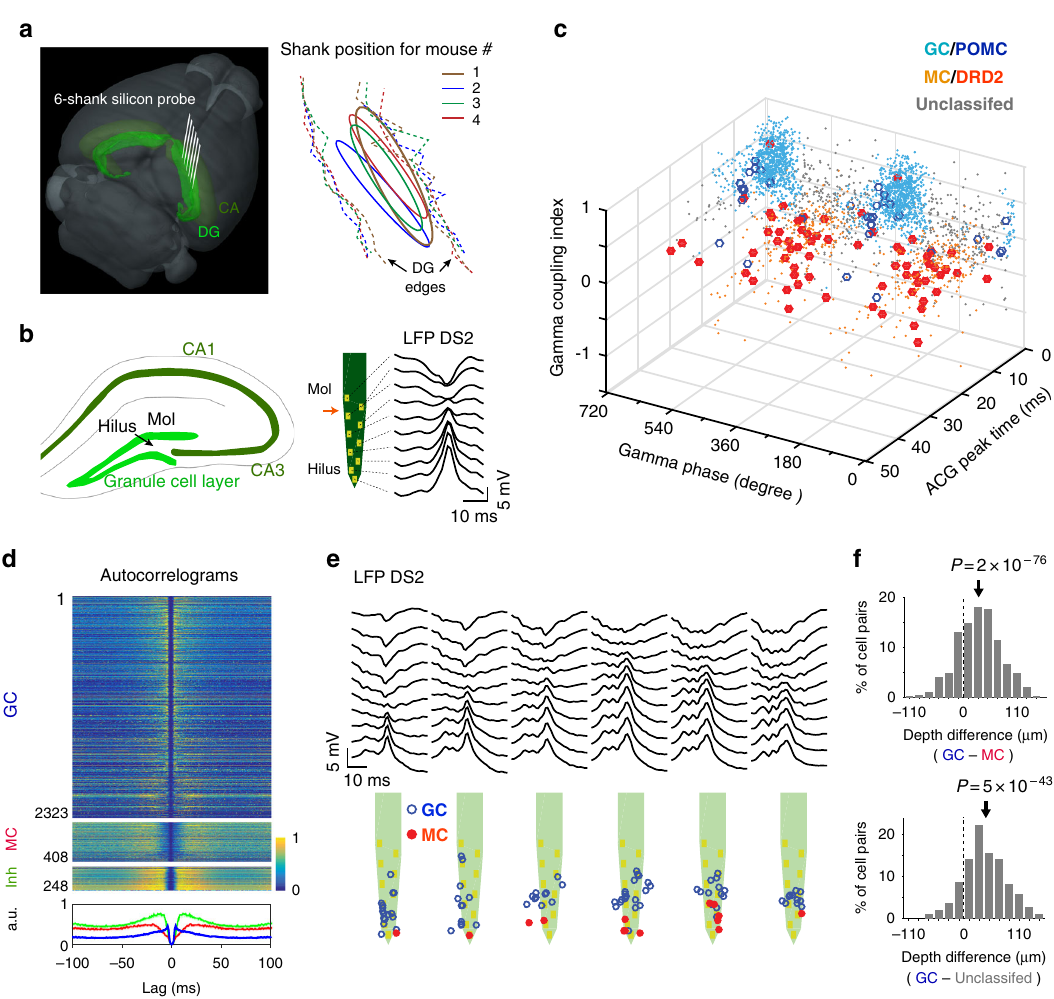
Fig. 1 Recording of putative GCs and MCs. a Left, 3D representation of the mouse brain (Allen Mouse Brain Institute; www.alleninstitute.org) showing recording electrode con fi guration in the dentate gyrus (light green). Dark green, cornus ammonis (CA). Right, the electrode positions (ellipsoid) relative to the lateral/medial edges of the granule cell layer (dashed lines) for all mice. b Left, scheme showing the location of the hilus and granule cell layer on a coronal section of the hippocampus. Right, layout of recording sites for a shank of the silicon probe and pro fi le of local fi eld potential dentate spike 2 (LFP DS2). Red arrow, position of DS2 reversal. c 3D scatter plot for cells ’ spike gamma phase, ACG refractory gap and gamma coupling index. Putative MCs (orange dots) and GCs (light blue dots) are identi fi ed by overlap with DRD2 (red fi lled circle) and POMC (blue circle) light-excited cells. d Spike ACGs (upper, color-coded representation of individual cell; lower, population average) for putative GCs (blue), MCs (red) and inhibitory cells (green). e Layout of LFP DS2 (upper) and putative GCs and MCs (lower) along the silicon probe shanks for one session. f Top, distribution of depth differences for all possible pairs of putative GCs and MCs recorded concurrently on the same shanks ( n = 825 pairs). Bottom, same analysis between GCs and the population of unclassi fi ed cells in panel ( c ) ( n = 301 pairs). Arrows, the means. P -values, two-tailed paired t low (<50 spikes) to reliably measure ACG refractory gaps and gamma phases.